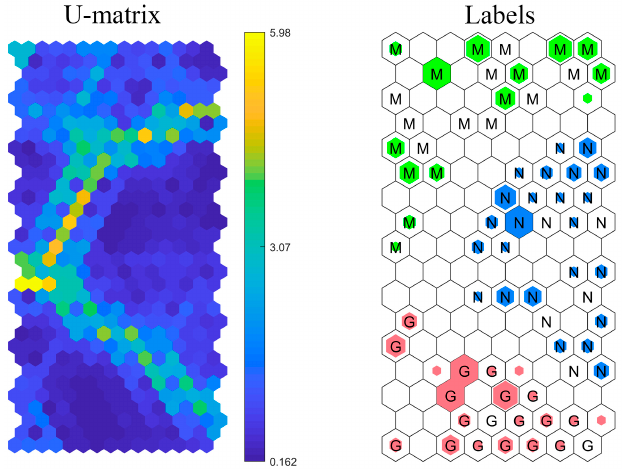
Figure 18. Illustration of training and testing results of SOM. Table 11. Diagnosis accuracy of the proposed method on the rotary torsional fatigue test. Fault